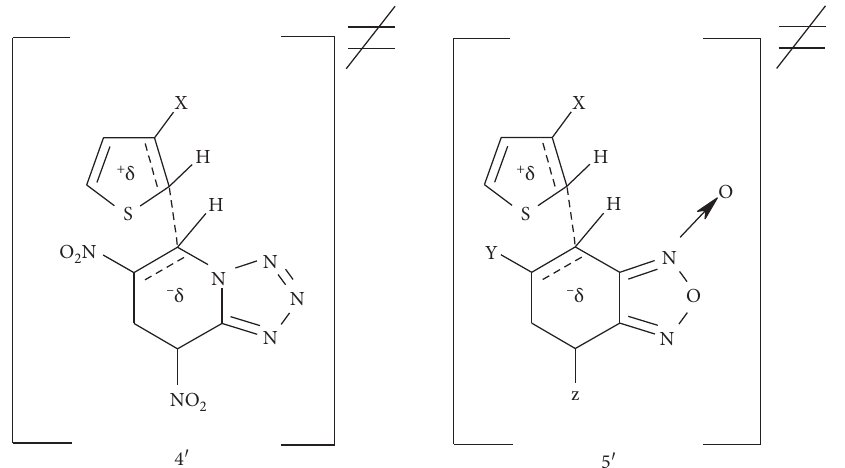
Figure 6: Proposed transitional state structures for σ -adducts 4 and 5 in